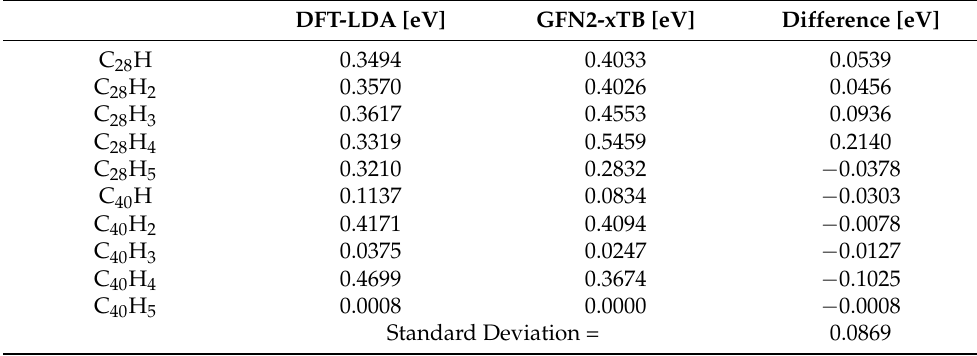
Table 1. Comparison of energy difference between lowest energy and second-lowest energy isomer in the calculated series, for C 28 H n and C 40 H n , n = 1 . . . 5, calculated at DFT-LDA and GFN2-xTB levels of theory (eV). The difference between these two values and the associated standard deviation is also given.